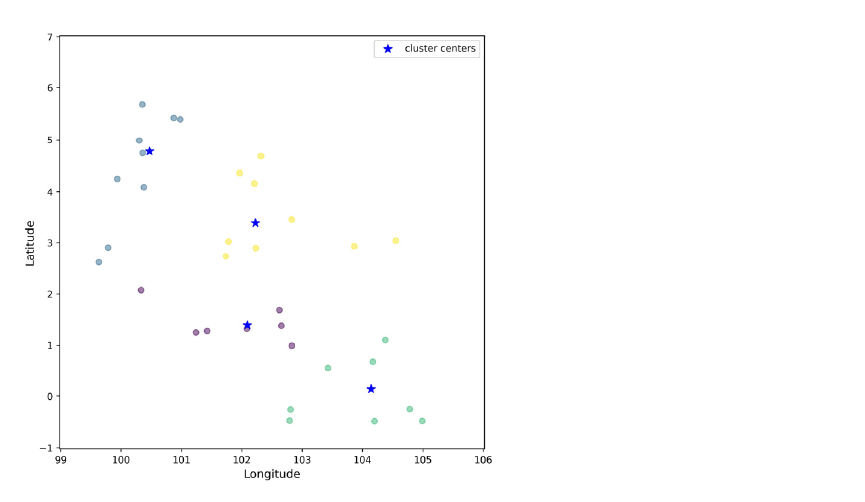
Figure 2. Fuzzy clustering results of flight position data at 11:30 UTC on 1 December 2019 (Singapore regional airspace).